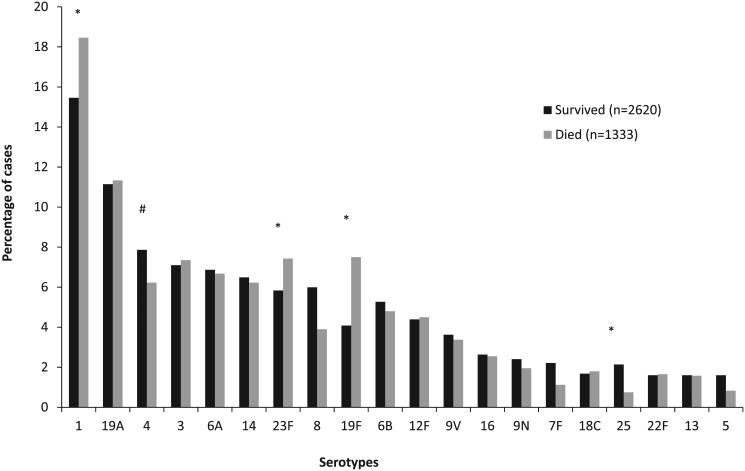
Distribution of pneumococcal serotypes amongst patients aged ≥15 years with invasive pneumococcal disease (IPD) in South Africa from 2003–2008, by in-hospital outcome.# Reference group. *Statistically significant at p<0.05